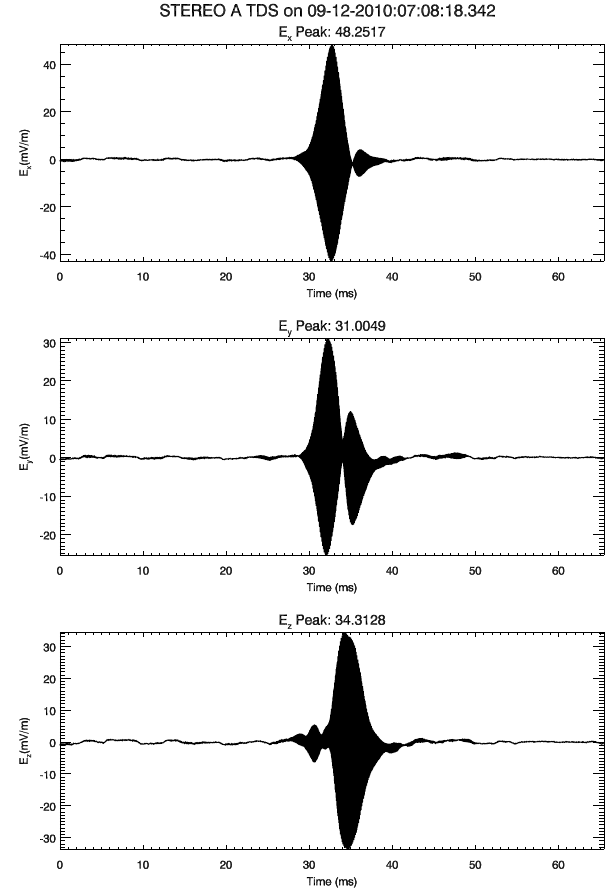
Fig. 2. The E x , E y and E z components of the Langmuir wave packet detected by the X , Y and Z antennas. The waveforms are in the spacecraft frame of